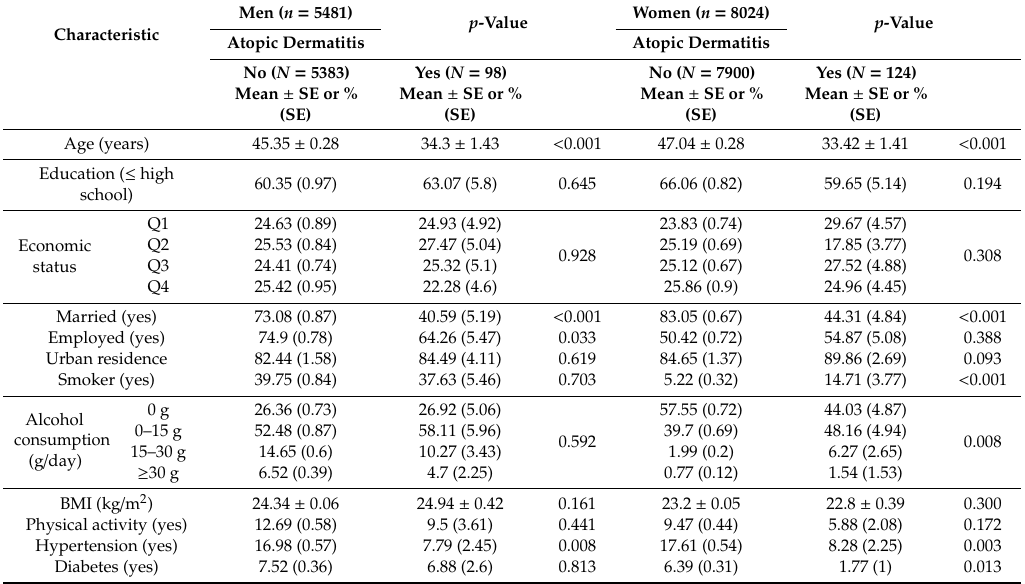
Table 1. Di ff erences in the prevalence of atopic dermatitis according to sex and clinical characteristics.